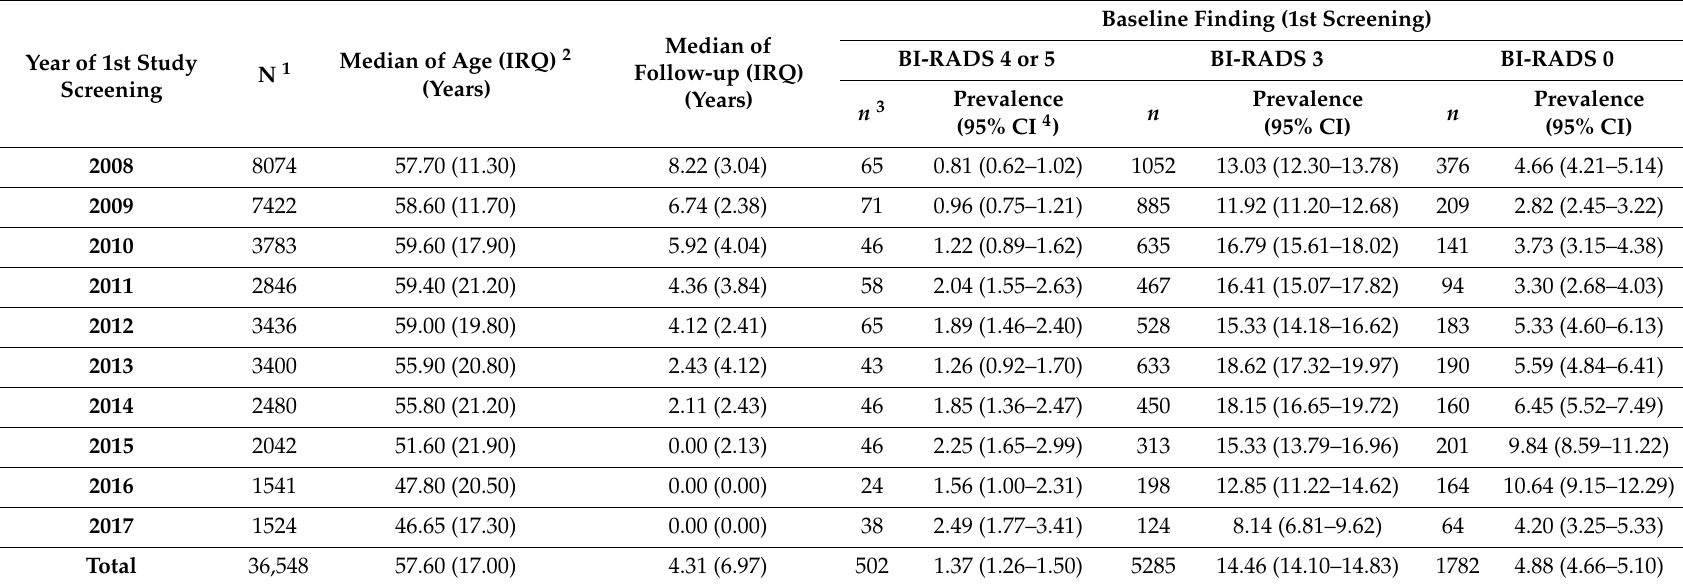
Table 1. Number of women enrolled in the study, including mean age of the first study screening and mean